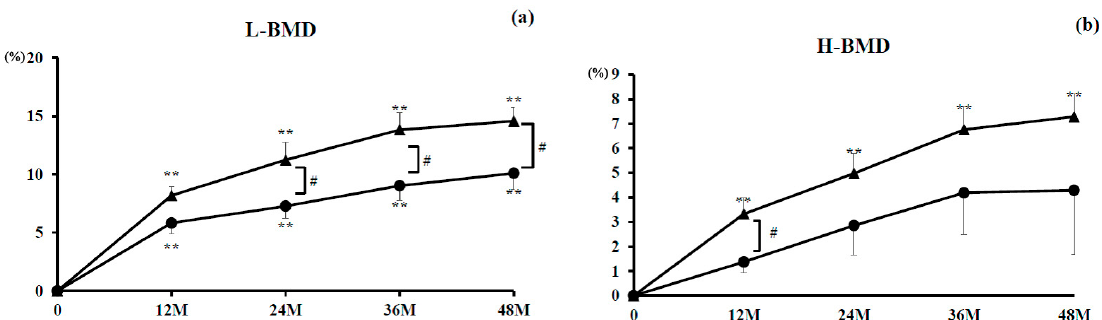
Figure 3. Percent changes in lumbar 1–4 spine bone mineral density (L-BMD) and total hip BMD (H-BMD). Closed circles indicate the denosumab monotherapy group and closed triangles indicate the combination group. Double asterisks denote a significant difference ( P < 0.01) compared with pretreatment values. Single hashtag denotes a significant difference ( P < 0.05) between the groups at indicated time points.